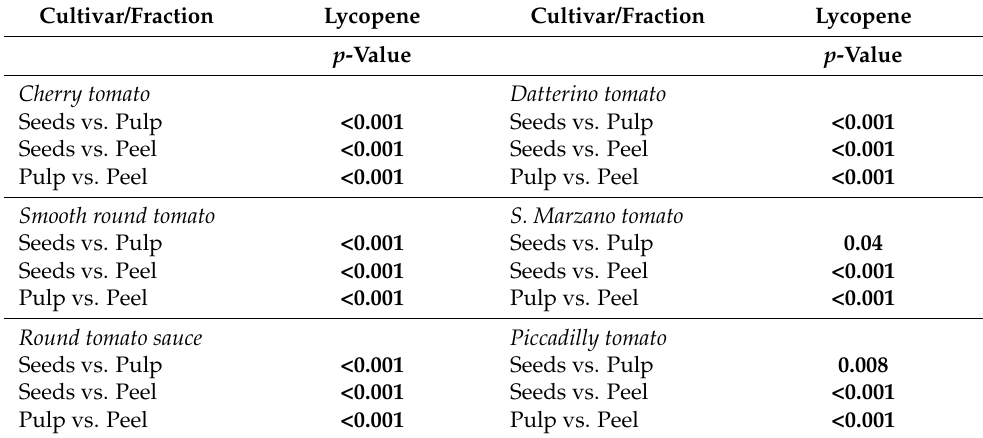
Table 2. Comparison among lycopene levels in the seeds, pulp, and peel fractions of each cultivar. Cultivar/Fraction